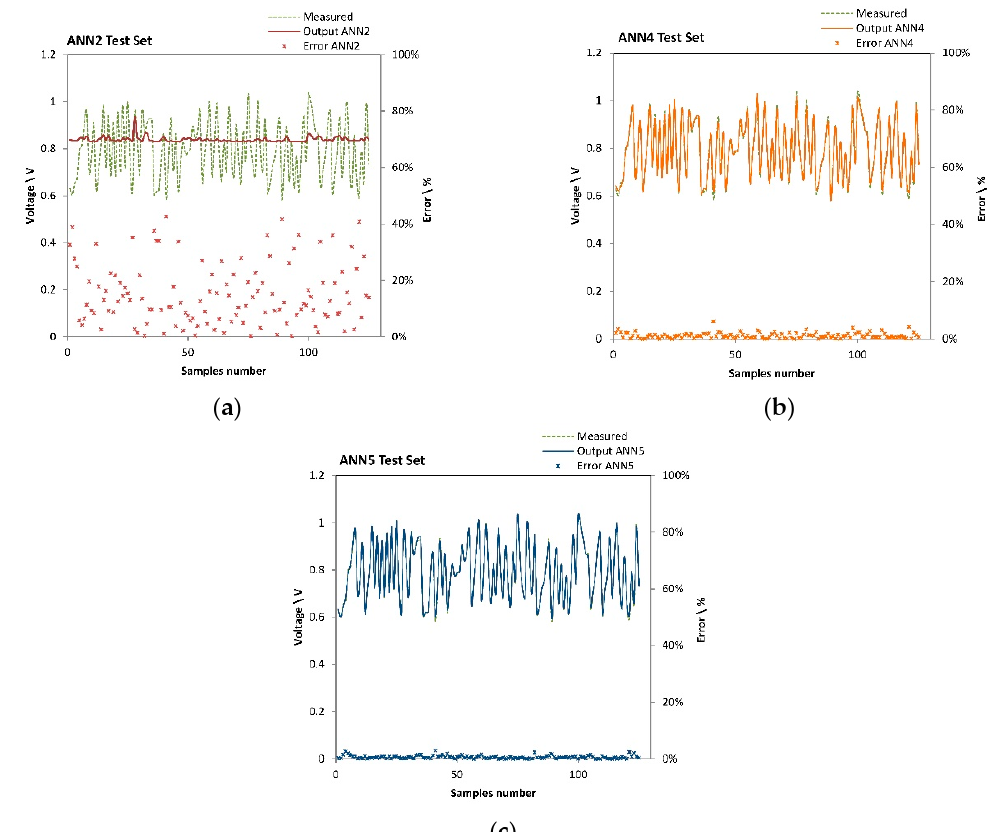
Figure 5. Test of ANN2 ( a ), ANN4 ( b ) and ANN5 ( c ) test: error dispersion.